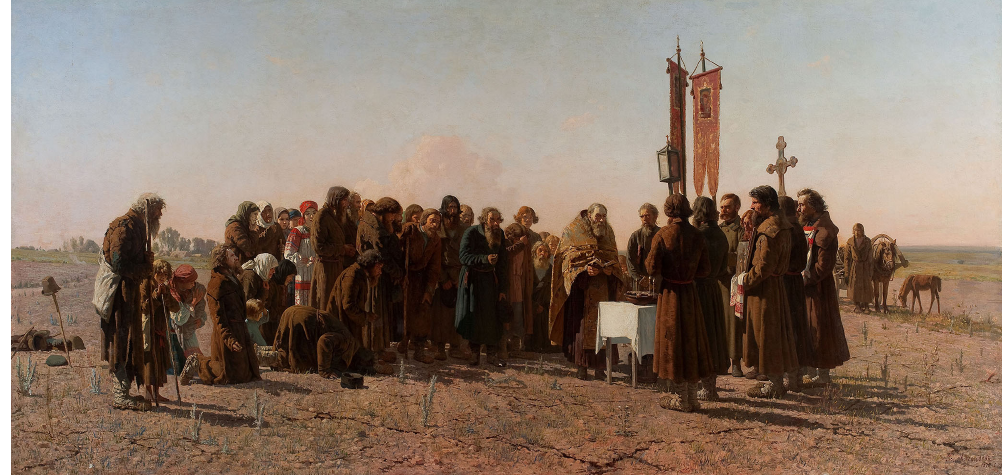
Figure 8. “Prayer in Time of Drought” by the Russian artist Grigoryi Grigorievich Myasoyedov (1834–1911, this work dating to between 1878 and 1881) shows poor people praying for rain, a traditional response to drought (Muzeum Narodowe w Warszawie, M.Ob.2365; Miasojedow Grzegorz G. (malarz); Prayer in Time of Drought ; 1878; oil; canvas; photo: K.